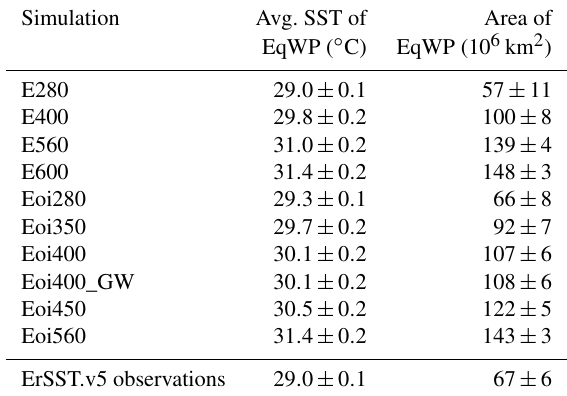
Table 3. Average temperature and extent of the equatorial warm pool (EqWP) for simulations with modern and mid-Pliocene geog- raphy. The EqWP is defined as the region where sea surface temper- ature (SST) exceeds 28 ◦ C (Watanabe, 2008). Standard deviations of SST and of the area of the EqWP are computed from annual mean data spanning 100 model years in the case of model simula- tions and from the 30 most recent years (1989–2018 CE) in the case of ErSST.v5 observations (Huang et al., 2017), which are given for reference.